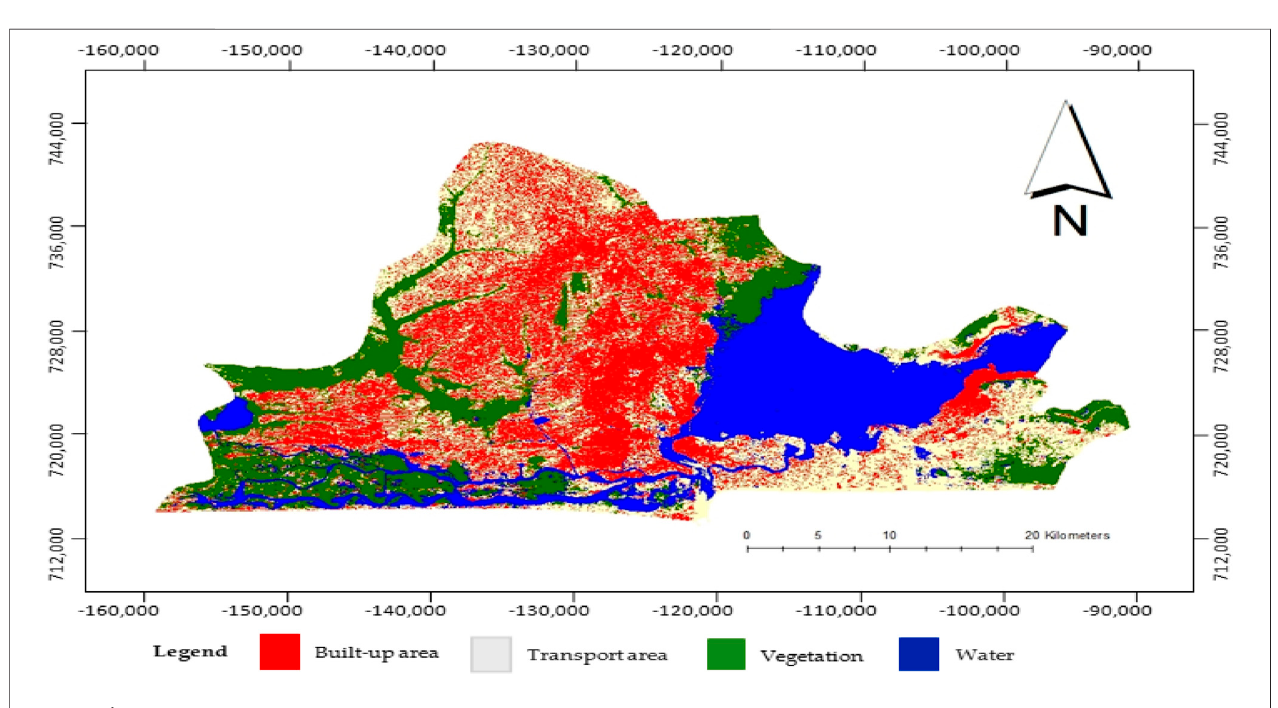
FIGURE 8 | Predicted LULC map in 2030.